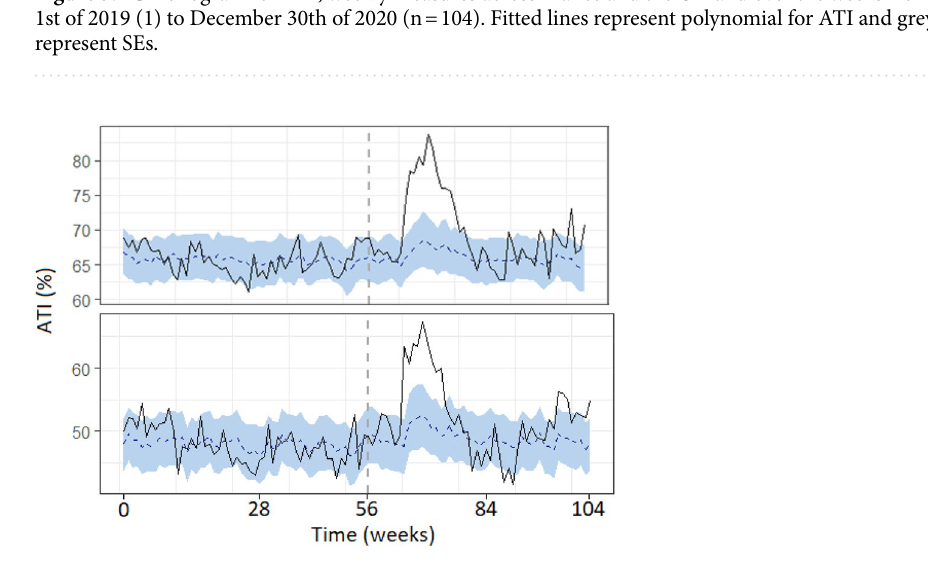
Figure 4. Chronogram of ATI weekly measures (dark line) relative to the synthetic predicted control time series (blue line). Measures are taken across France (below) and the UK (above) over the weeks from January 1st of 2019 (1) to December 30th of 2020 (n = 104). Vertical dashed grey lines represent the beginning of the COVID-19